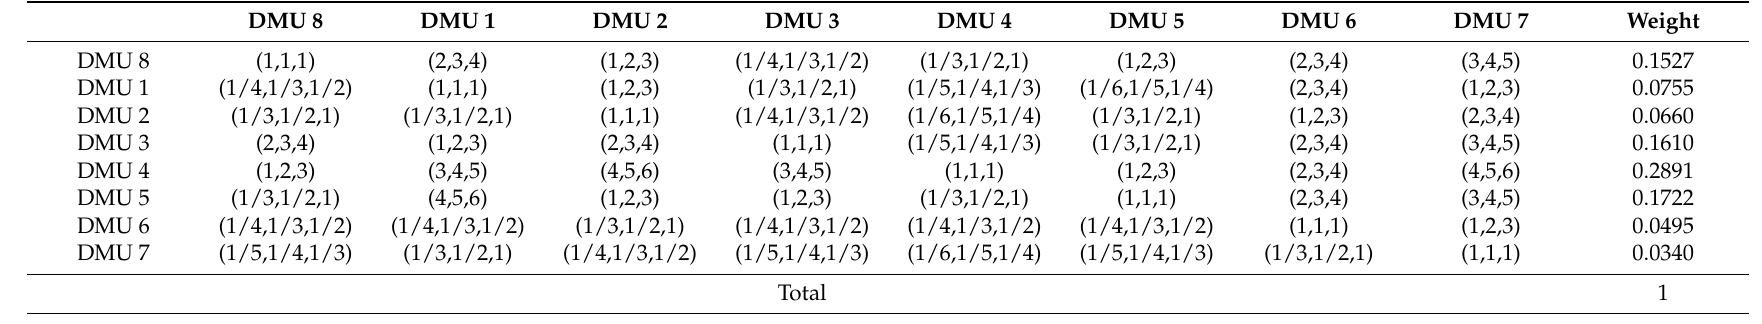
Table A26. Comparison matrix for EOP based on alternatives.